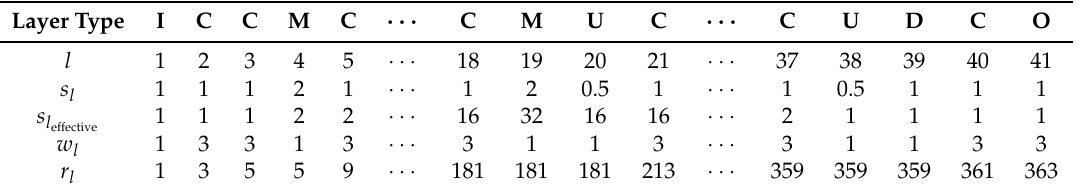
Table 3. Sampling of the receptive field calculations at the output of every layer of the proposed network. The different types of layers are abbreviated with the following notation: I: input image, C: convolution block, M: max pooling, U: max unpooling, D: depth concatenation, O: output